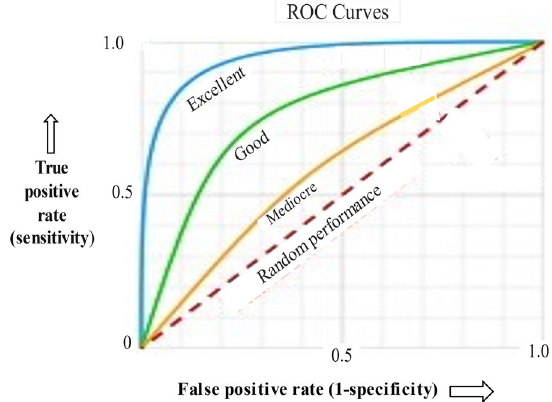
Fig. 3 Receiver operating curves (ROC) for different levels of noise. See text for